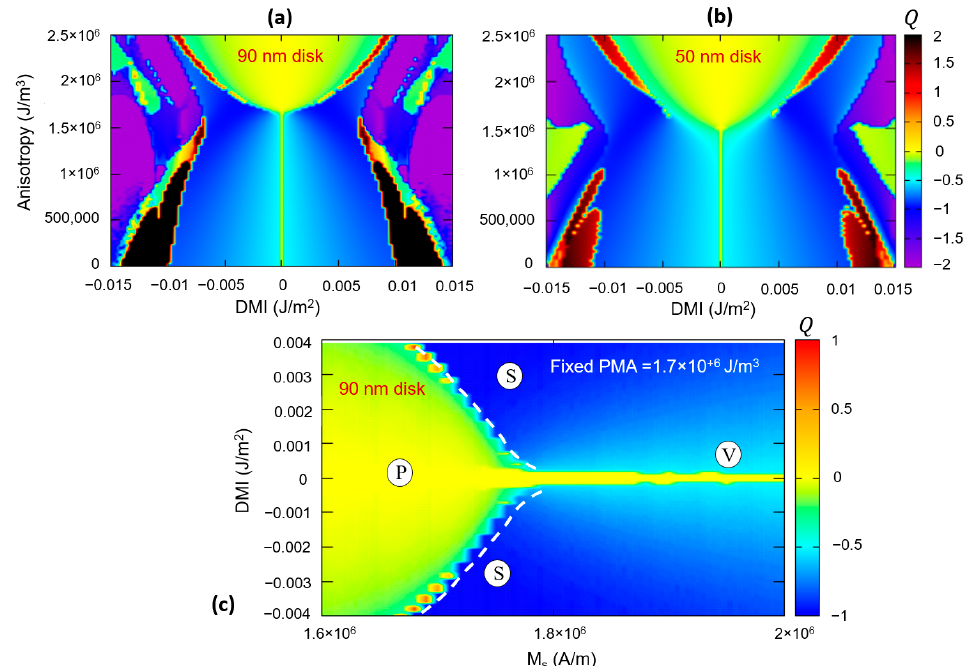
Figure 19. The influence of the ferromagnetic disk size on the DMI-PMA-Q ground state phase diagram. ( a ) 90 nm diameter disk ( b ) 50 nm diameter disk ( c ) M s -DMI-Q phase diagram indicating the maximum DMI required to promote skyrmionics (S) state instead of vortex (V) for a given M s